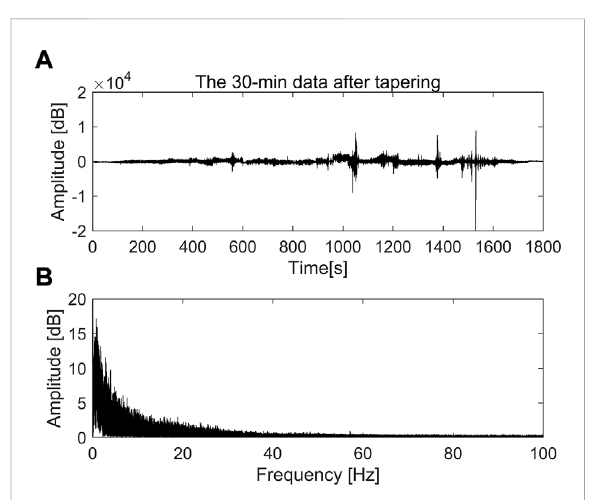
FIGURE 7 (A) Waveform, and (B) corresponding spectrum of the resampled 30-min record of Channel 200 in Line II. The red box denotes the high amplitude signal caused by environmental and human